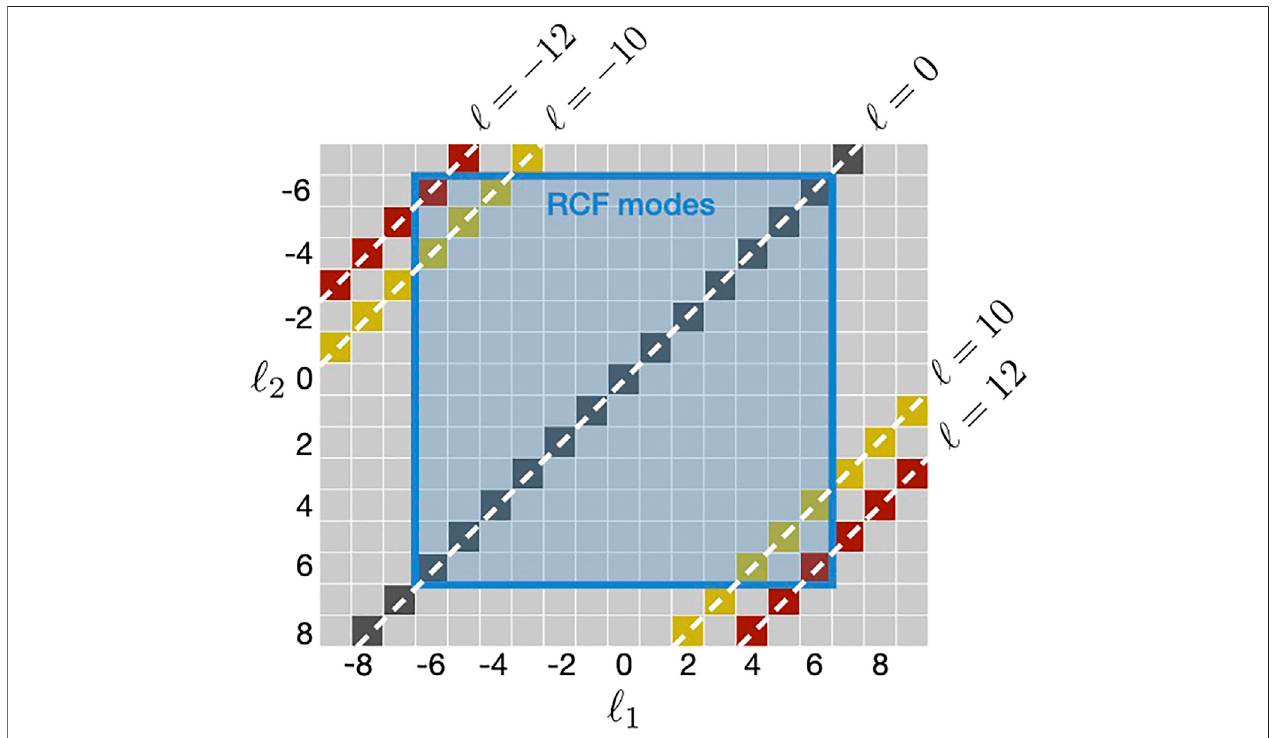
FIGURE6| IllustrationofstateengineeringusingOAMcorrelationsfromSPDCandmode fi lteringprovidedbyringcore fi bers(RCF).OAMcorrelationsbetweenthe pumpbeamanddown-convertedphotonsproducephotonswithOAMdistributedalongthediagonaldirections.TheRCFselectsmodeswithintheshadedbluesquare. Thus, only OAM mode pairs along the diagonals within the square will